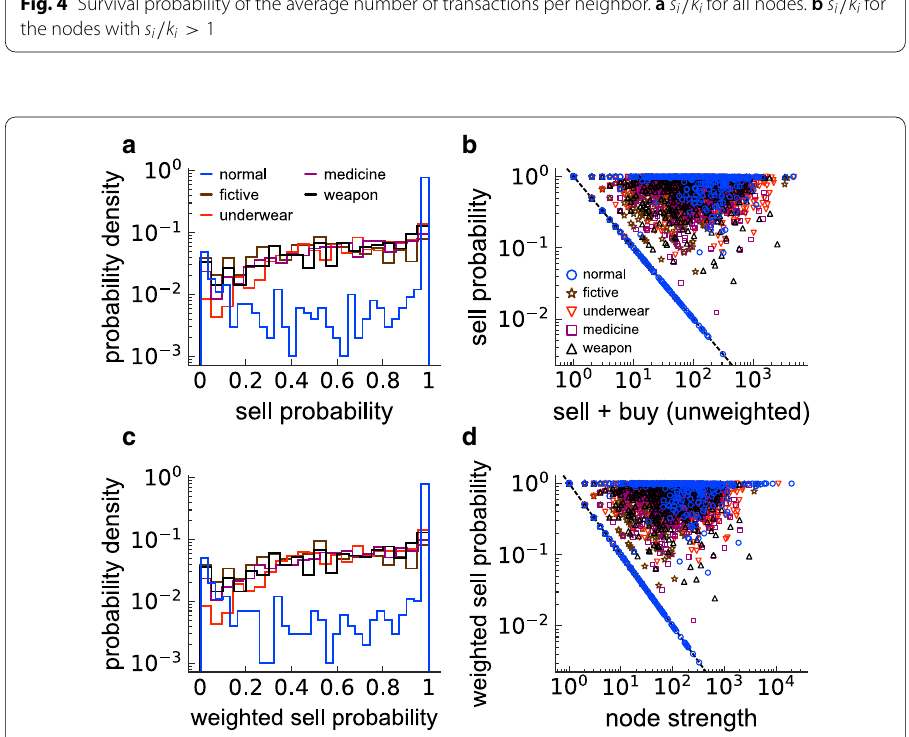
Fig. 5 Sell probability for each user type. a Distribution of the unweighted sell probability. b Relationship between the degree and the unweighted sell probability. c Distribution of the weighted sell probability. d Relationship between the node strength and the weighted sell probability. The dashed lines in b , d indicate k out s out 1 /( k in 1 /( s in i ) and i ) , i + i +